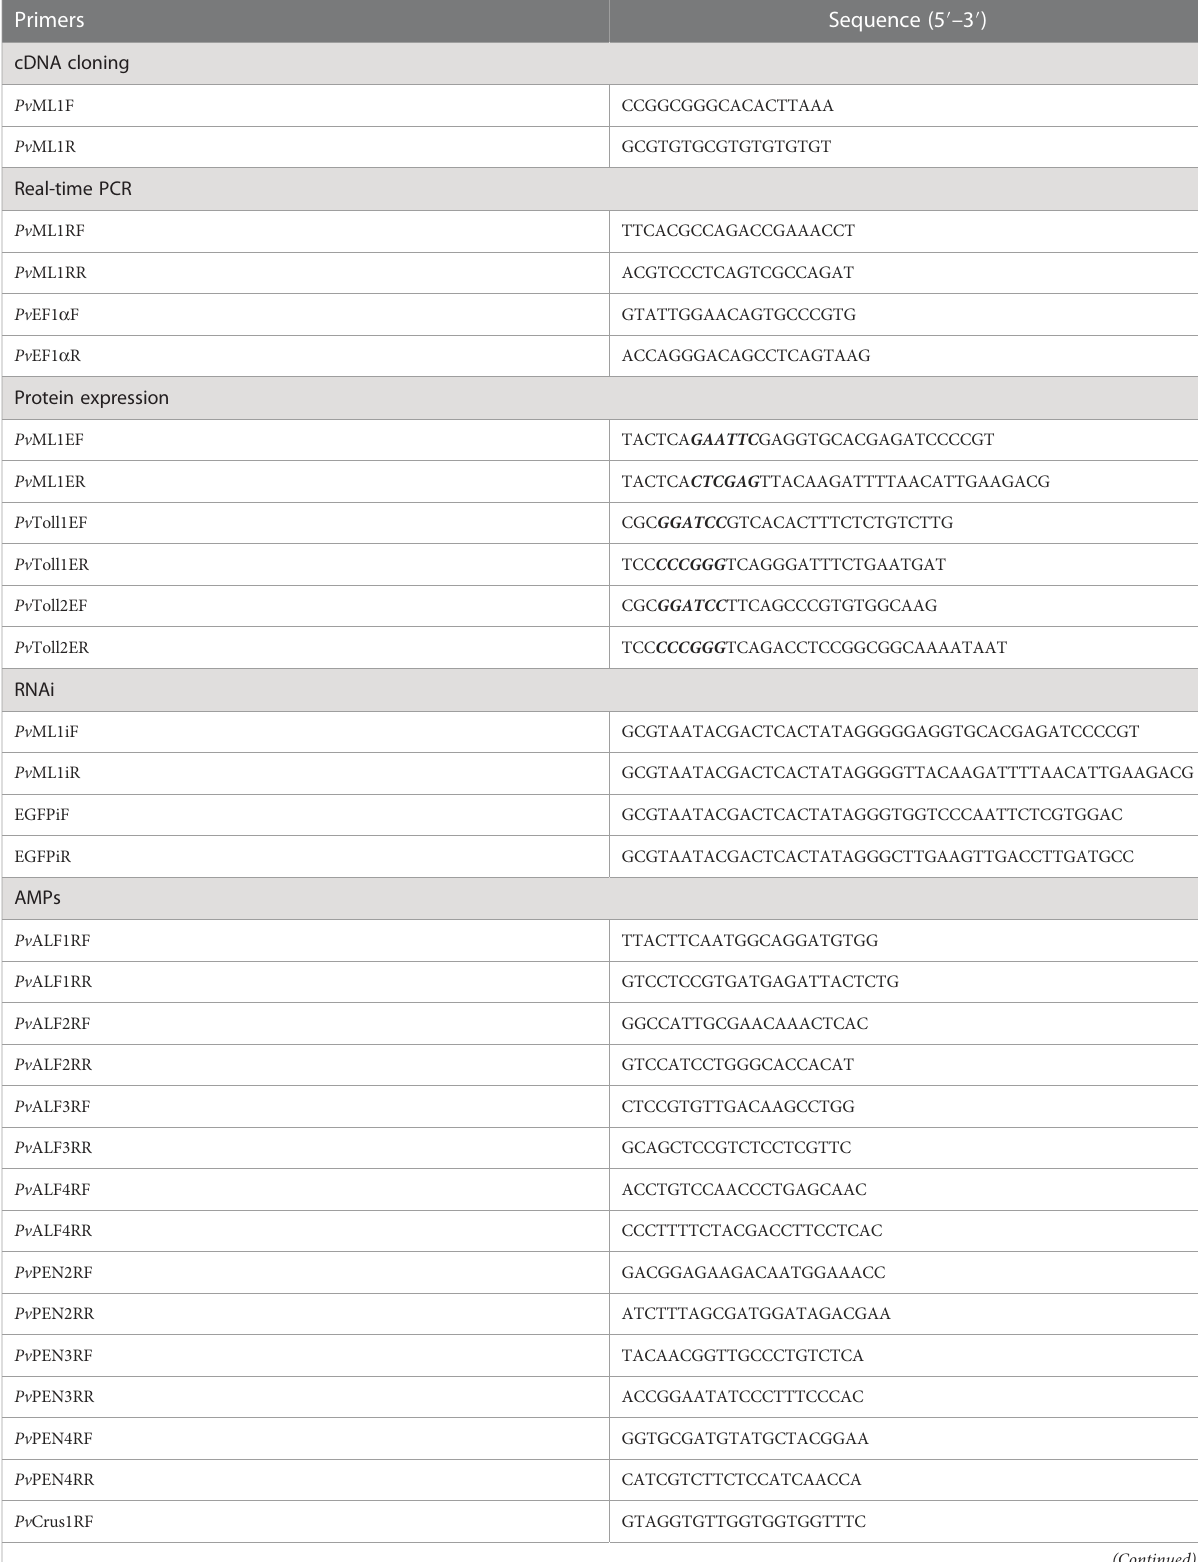
TABLE 1 Sequences of primers used in this